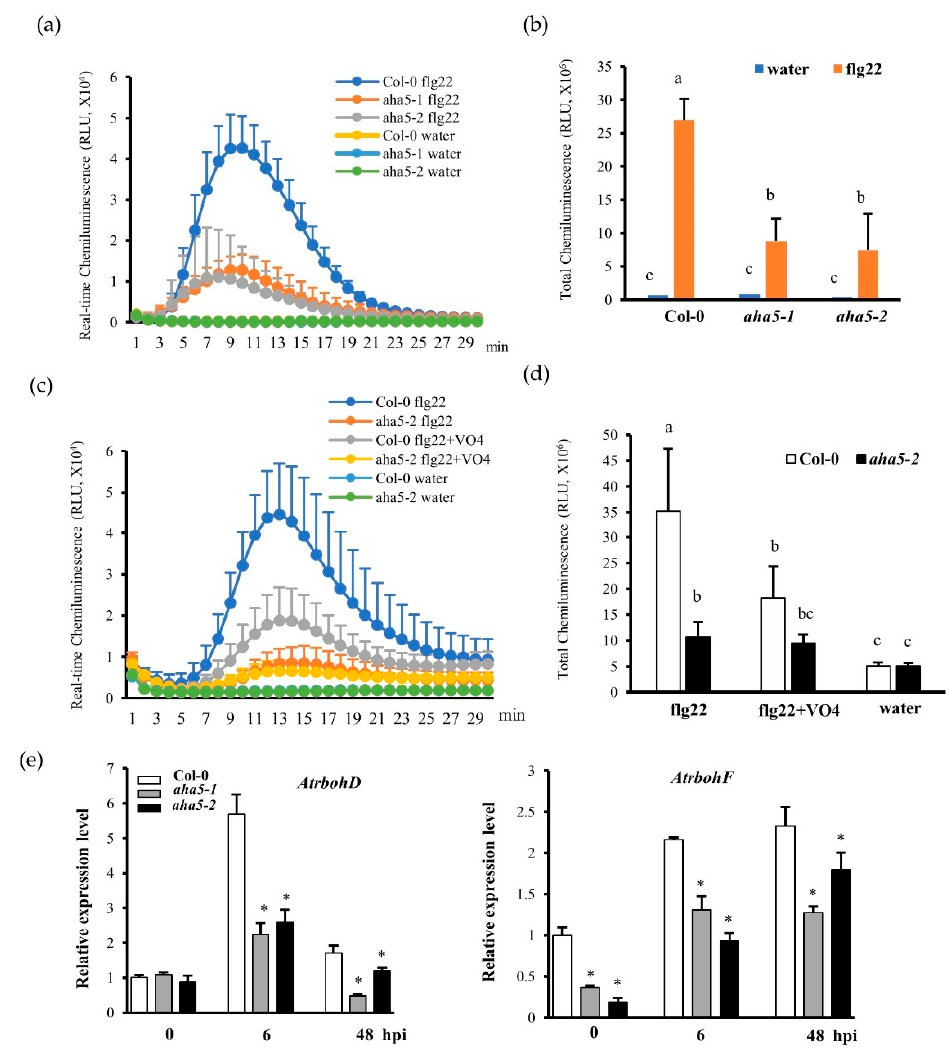
Figure 3. The aha5 mutant plants showed the decreased H 2 O 2 production and lower levels of gene expressions related to ROS production in response to the PAMP treatment. ( a ). The real-time H 2 O 2 burst curve of aha5 mutants and Col-0 plants in response to the PAMP flg22 and water treatments. Leaf discs (7 mm in diameter) of aha5 mutants and Col-0 plants were pretreated with sterile water for 18 h. Those pretreated leaf discs were further treated with water and 1 µM flg22. The H 2 O 2 induction was monitored by checking the luminescence for 30 min using a GLOMAX luminometer. ( b ) The total H 2 O 2 production analyzed from the real-time H 2 O 2 burst curve of aha5 mutants and Col-0 plants upon 1 µM flg22 induction and water treatment. This experiment was repeated three times with similar results. ( c ) The real-time H 2 O 2 burst curve of aha5-2 mutant and Col-0 plants to the flg22 induction with and without sodium vanadate (VO4) treatment. The leaf discs of aha5-2 mutant and Col-0 plants were treated with water or 1 µM flg22 (with and without VO4 treatment). The H 2 O 2 generation was monitored by checking the luminescence for 30 min using a GLOMAX luminometer. ( d ) The total H 2 O 2 production of aha5-2 and Col-0 plants upon 1 µM flg22 induction with and without the VO4 treatment were calculated from the real-time H 2 O 2 burst curve. The results in ( b , d ) represent means ± SE (n = 3), which are from one of the three independent repeats with consistent results. Different letters a–c within the figure ( b , d ) indicate significant differences at p < 0.05, which were calculated by a one-way analysis of variance (ANOVA) using SPSS ver. 21. (IBM SPSS Statistics, New York, NY, USA). ( e ) The relative gene expression of AtrbohD and AtrbohF in WT Col-0 and aha5 mutants was measured by qPCR and normalized to the expression of UBIQUITIN . The data represent means ± SE (n = 4) from one of the three independent repeats with consistent results. Expression was shown as the untreated average fold for Col-0. Significant differences